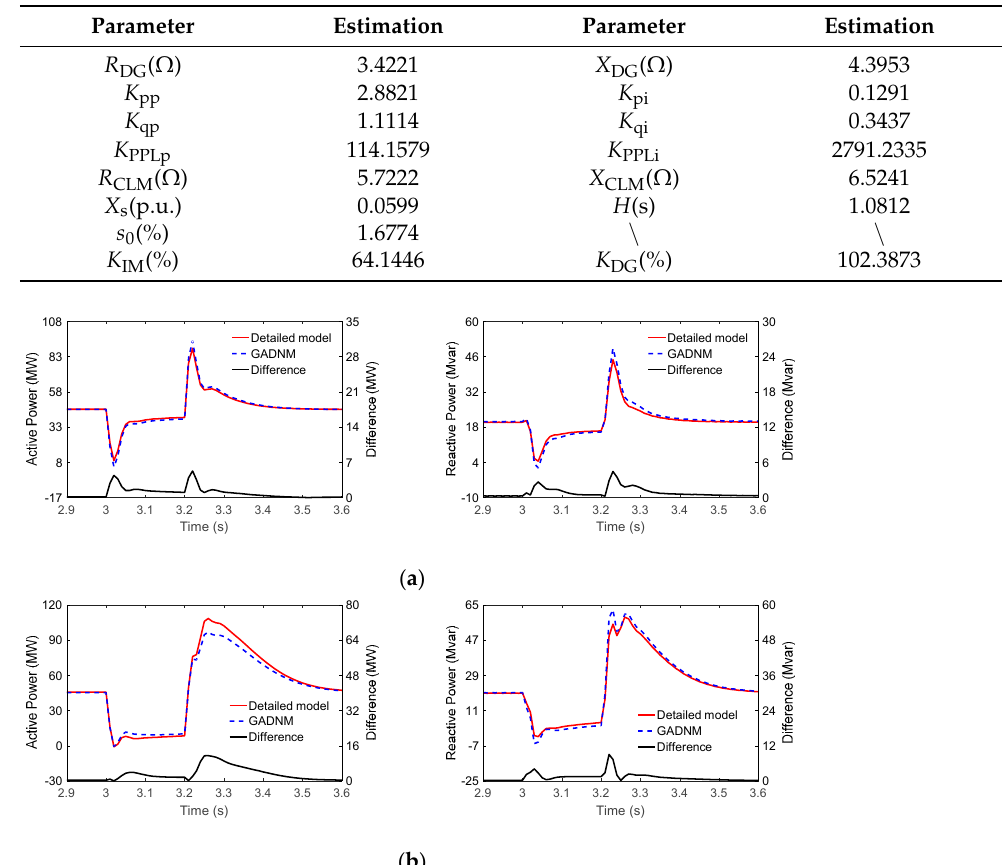
( a ) ( b ) Figure 12. Responses of the two voltage dip disturbances with